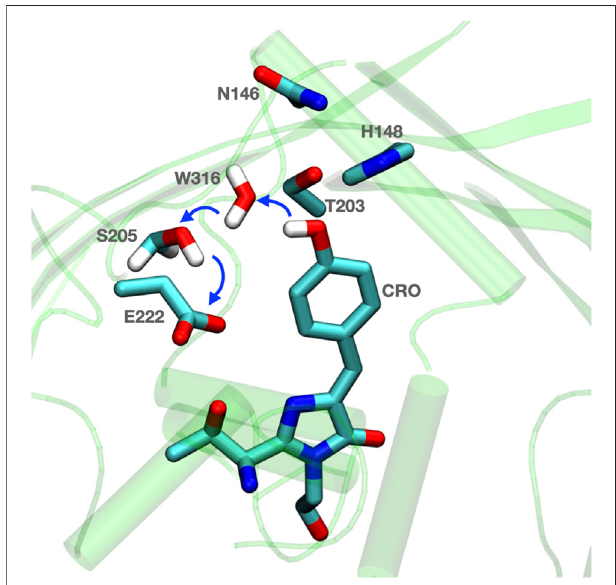
FIGURE 1 | Residues are prearranged for Grotthuss proton transfer in GFP. Blue thick arrows show direction of proton transfer from chromophore (CRO) to E222 via water (W316) and S205. The surrounding H148 and N146 can help to anchor the active proton transfer path. The coordinates for Equorea victoria GFP are from PDB ID: 1EMA (Ormö et al.,